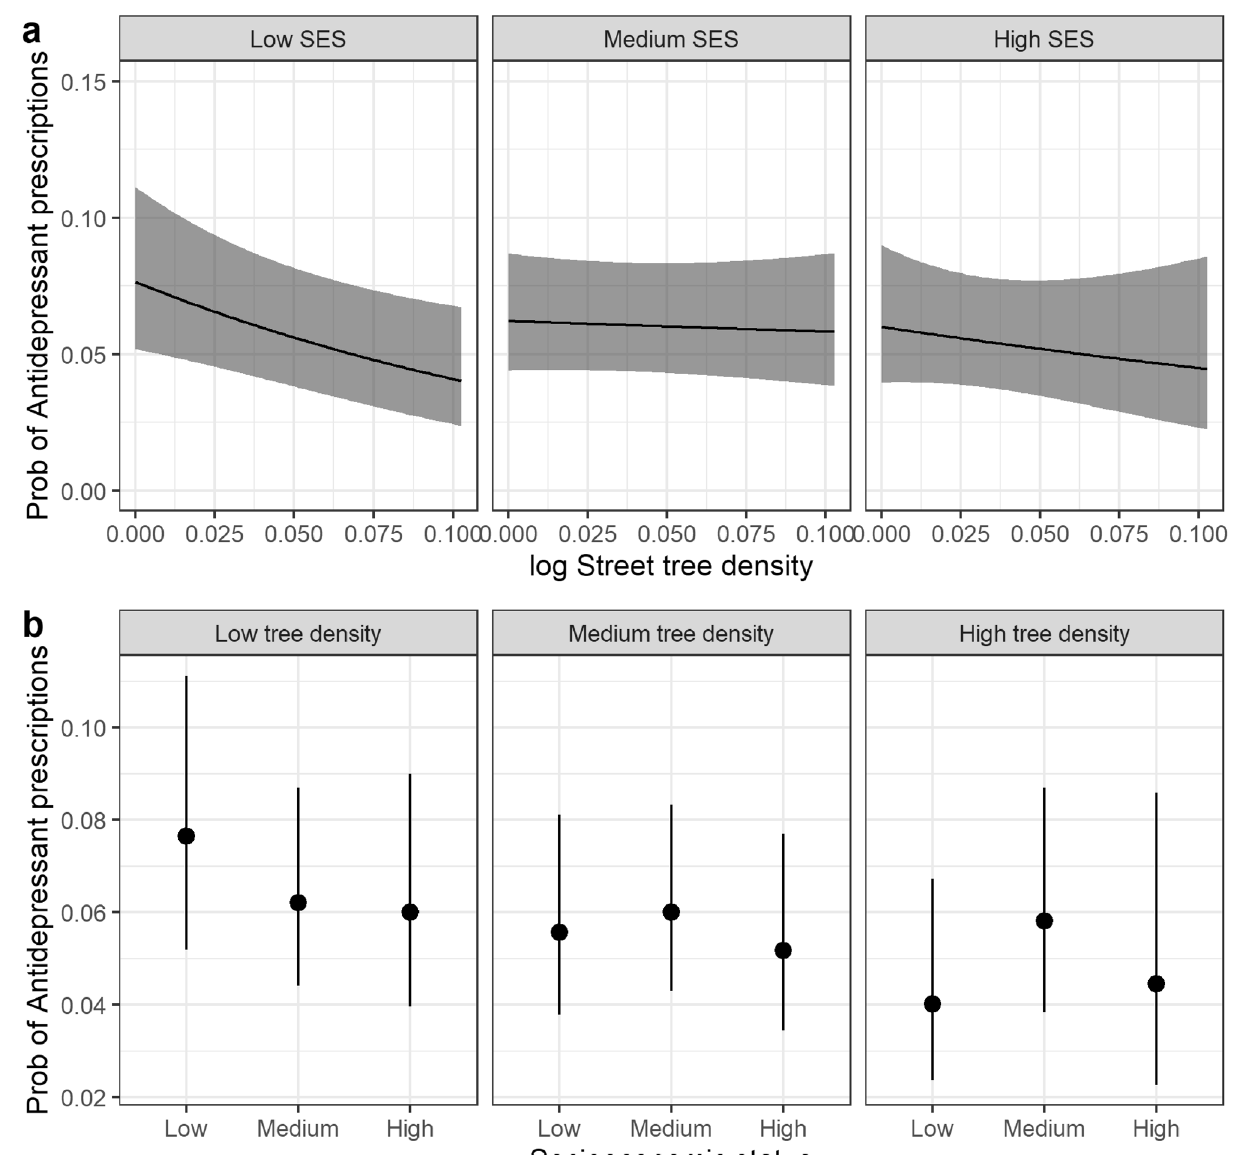
Figure 4. ( a ) Probability of antidepressant prescriptions as a function of street tree density 100 m around the home and individual socio-economic status (SES). The black line is the mean and the shaded area are the 95% confidence intervals. The regression is statistically significant ( p < 0.01) for low SES but not for medium or high SES. ( b ) Probability of antidepressant prescriptions as a function of low (0), medium (average) and high (max) street tree density 100 m around the home stratified by SES. The black dot is the mean and the black line is the 95% confidence